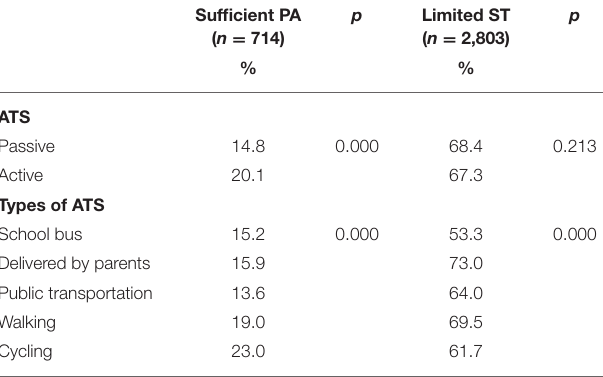
TABLE 1 | Characteristics of participants in this study. TABLE 2 | Difference of PA and ST by ATS and its